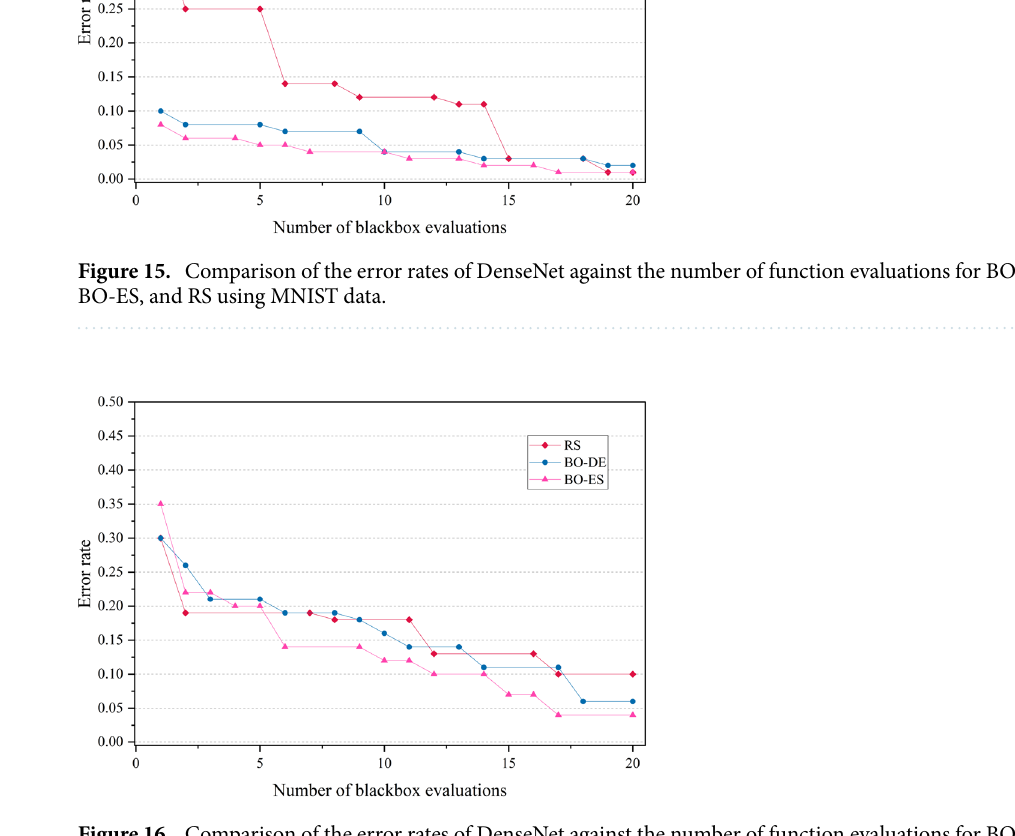
Figure 16. Comparison of the error rates of DenseNet against the number of function evaluations for BO-ES, BO-ES, and RS using SVHN